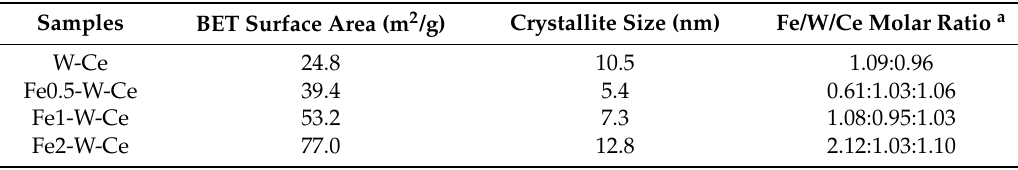
Figure 2. XRD patterns of Fe-W-Ce catalysts. Table 1. Specific surface area and crystallite of different catalysts.